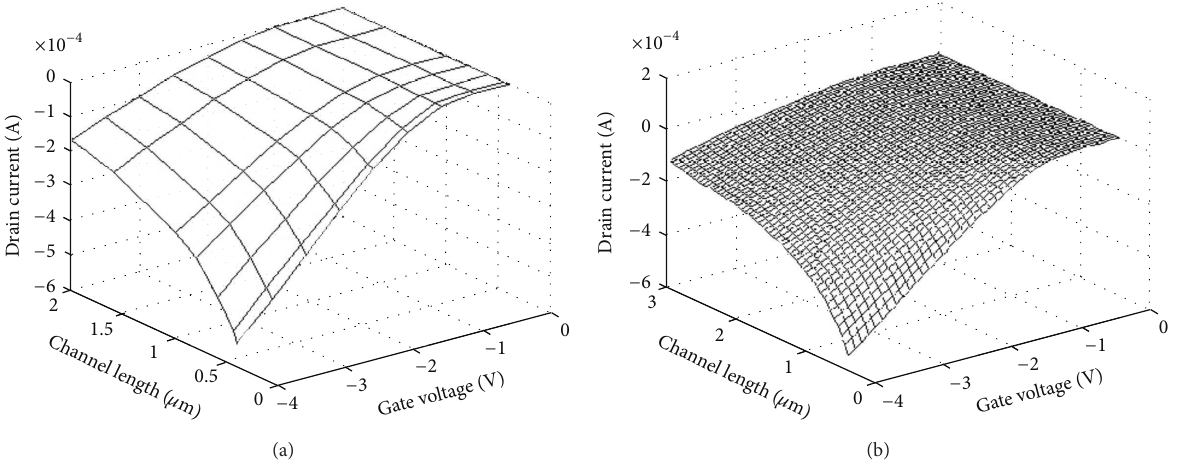
Figure 4: The 3D-like 𝐼 𝑑 (a) measurement data surface and (b) prediction data surface versus 𝐿 and 𝑉 𝑔 of the group 1A samples (as 𝑉 𝑑 = −3 V).